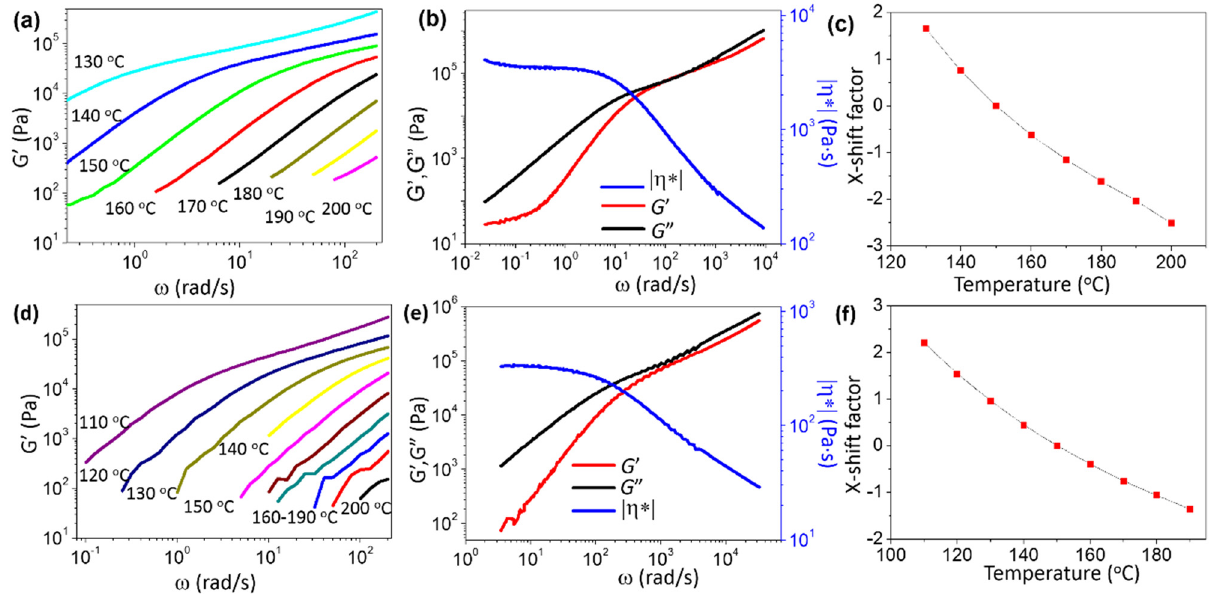
Figure A2: ( a ) Storage modulus ( G ′ ) versus angular frequency ( ω ) at temperature from 130°C to 200°C for ( S 15.4 ) 3 , ( b ) the master curve at the reference temperature of 150°C for ( S 15.4 ) 3 , ( c ) the X - shift factor versus temperature for ( S 15.4 ) 3 , ( d ) storage modulus ( G ′ ) versus angular frequency ( ω ) at temperature from 110°C to 200°C for ( S 15.4 - 0.94 - B 1.4 ) 3 , ( e ) the master curve at the reference temperature of 150°C for ( S 15.4 - 0.94 - B 1.4 ) 3 , and ( f ) the X - shift factor versus temperature for ( S 15.4 - 0.94 - B 1.4 ) 3